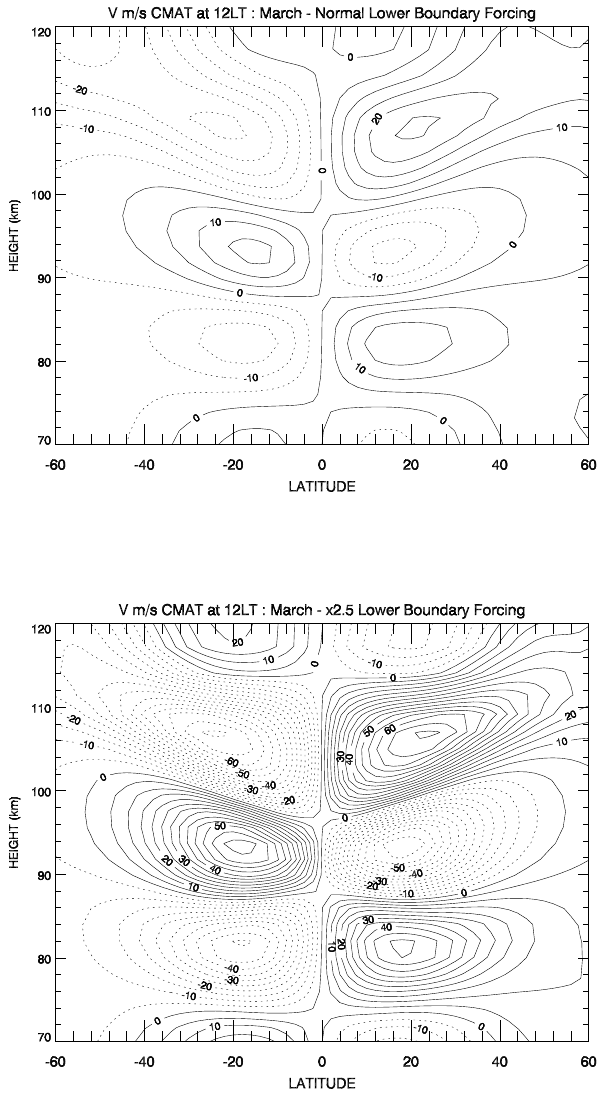
Fig. 3. Meridional winds (ms − 1 ) as calculated by CMAT for March at 12:00LT, with normal lower boundary diurnal tidal forcing (top), and × 2 . 5 lower boundary diurnal tidal forcing (bottom) southward wind contours are